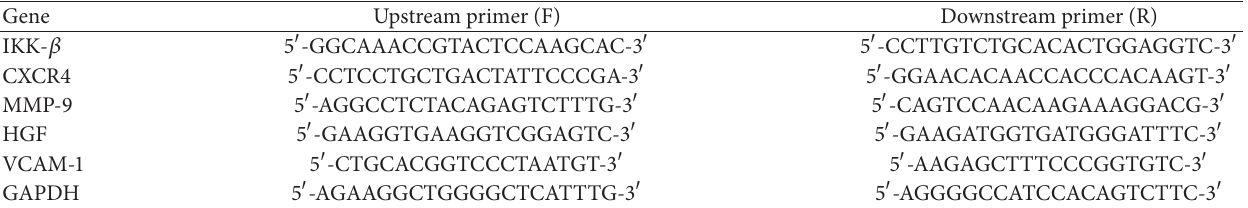
Table 2: RT-PCR primers